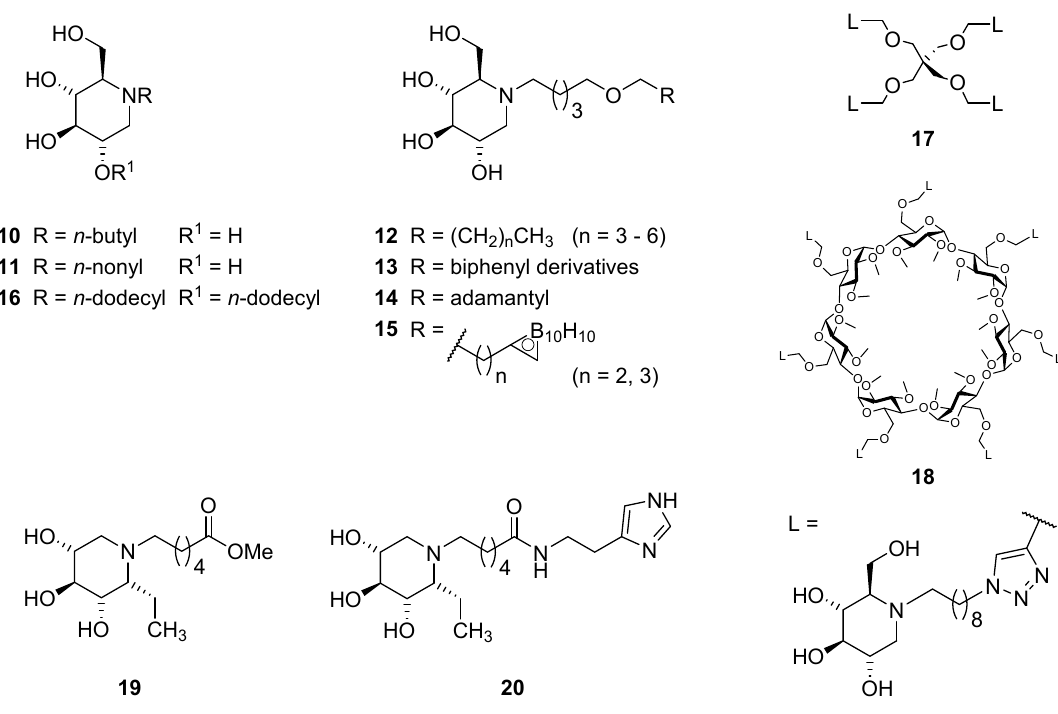
Figure 3. Selected structures of N -alkylated iminosugars.